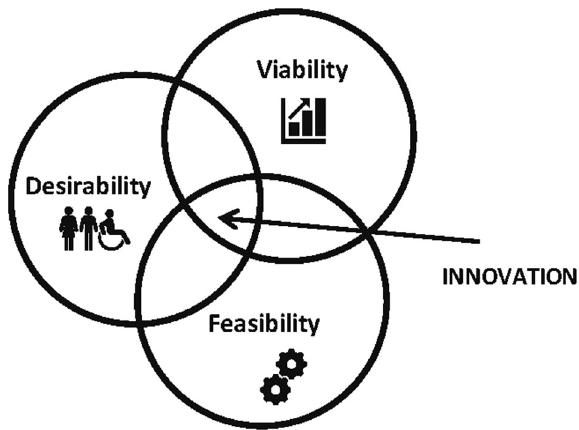
Fig. 1 Innovation dimensions by IDEO: feasibility-viability-desirability (after IDEO, 2009).